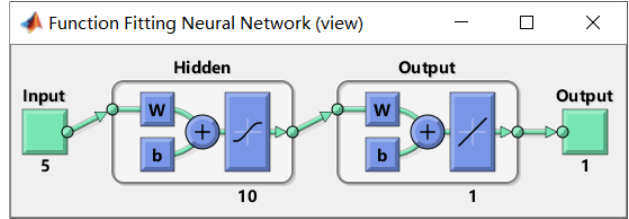
Figure 13. Neural network structure diagram.